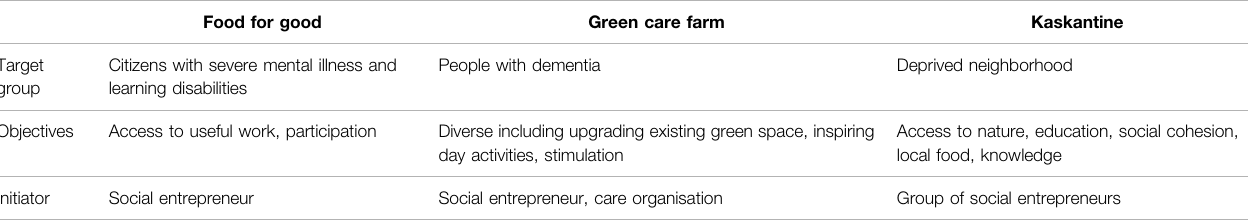
TABLE 3 | Overview of the three